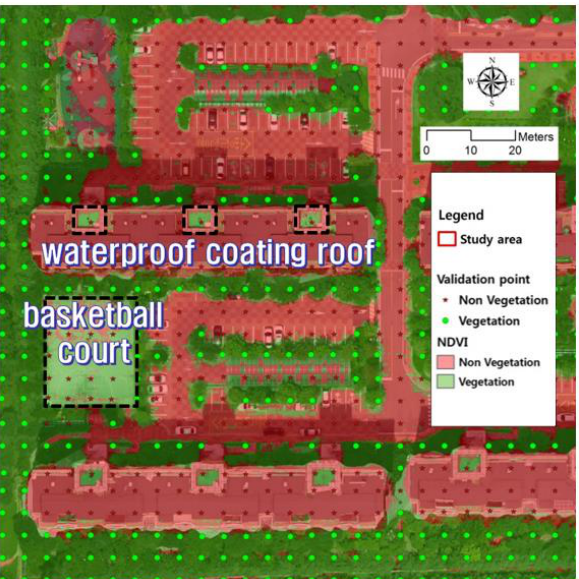
Figure 18. Vegetation map classified by applying only NDVI around the basketball courts and the waterproof coating roofs.